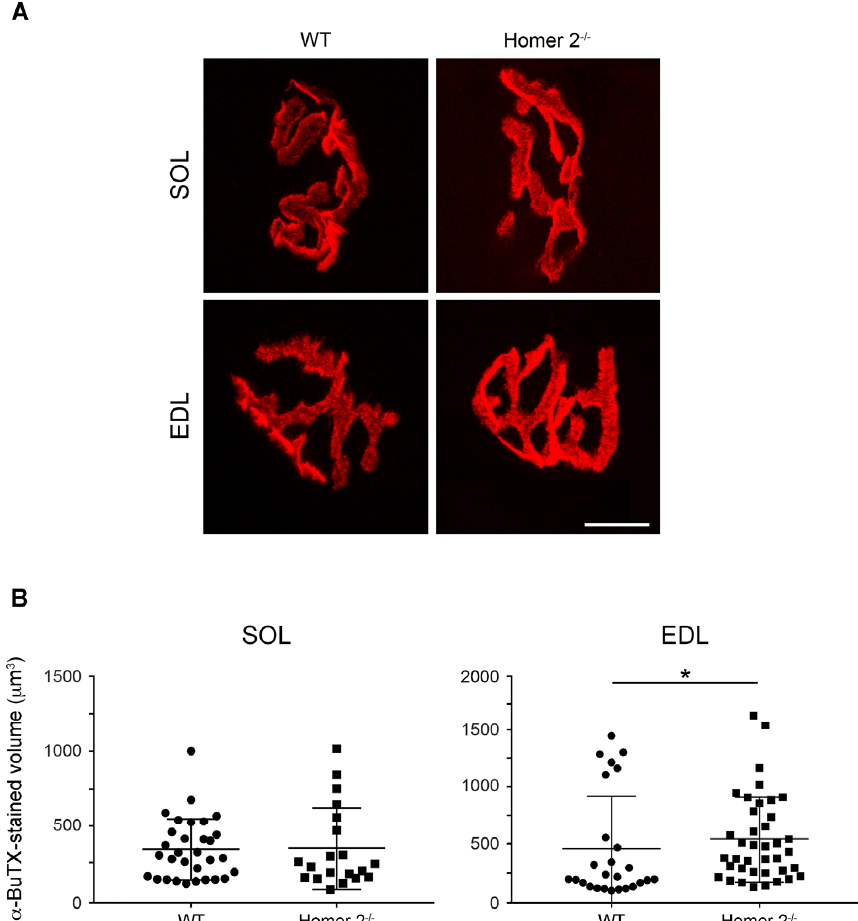
Figure 4. Endplate volume in either SOL and EDL from WT and Homer 2 -/- mice. ( A ) SOL and EDL cryosections were stained for nAChRs with Alexa-555- α -BuTX (see the Materials and Methods section for details). Scale bar, 10 µ m. ( B ) The endplate volume was calculated both in SOL and EDL as described in the Section 4 [24]. For each group, SOL and EDL from 4 mice were analysed and at least 20 endplates per group were examined. Data are expressed as mean ± SEM. Statistical differences were determined by Mann–Whitney test. * p < 0.05 vs. the respective WT